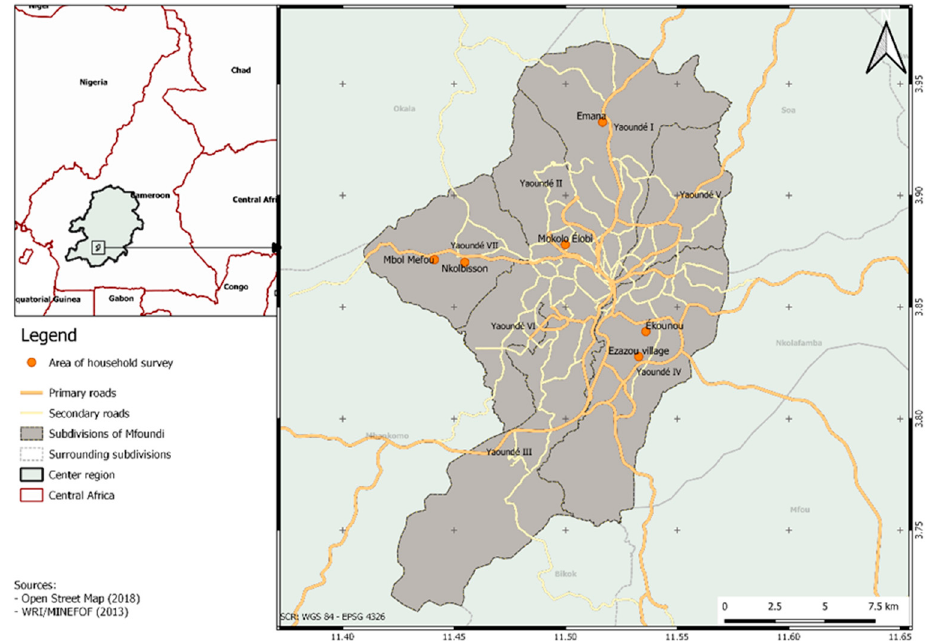
Figure 1. The location of the selected lowland areas in Yaoundé, Cameroon.